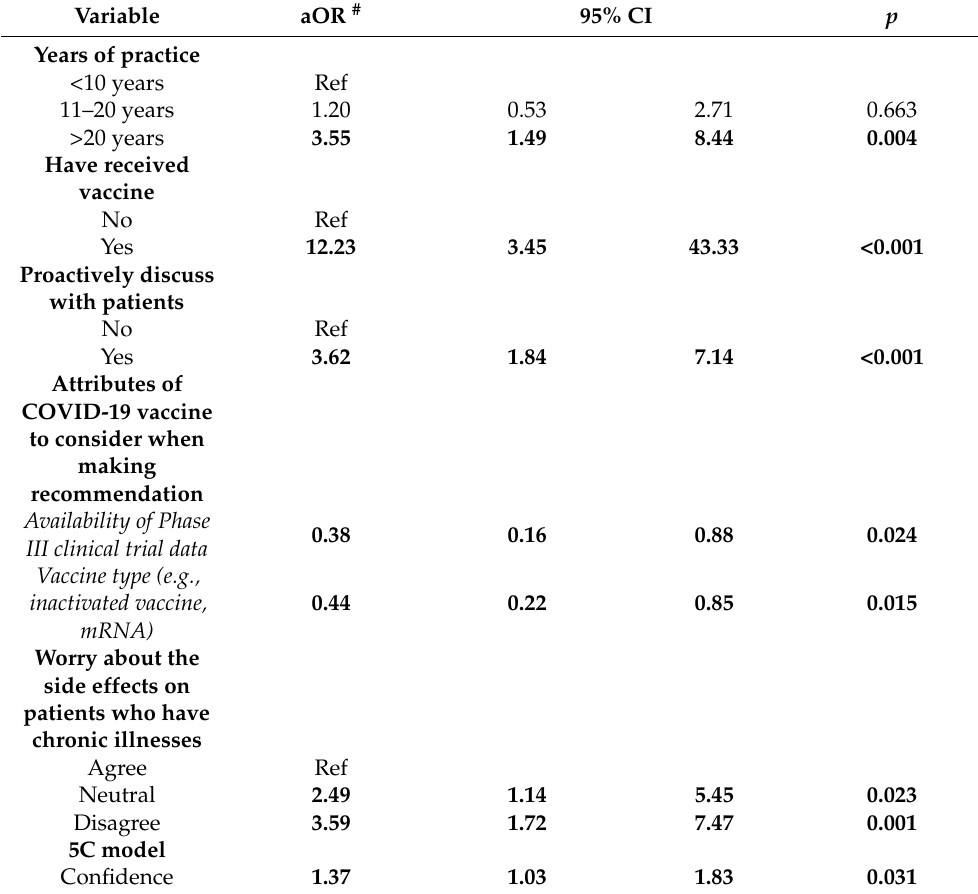
Table 4. Stepwise logistic regression * to identify independent predictors of making COVID-19 vaccination recommendations to patients by family doctors (N =